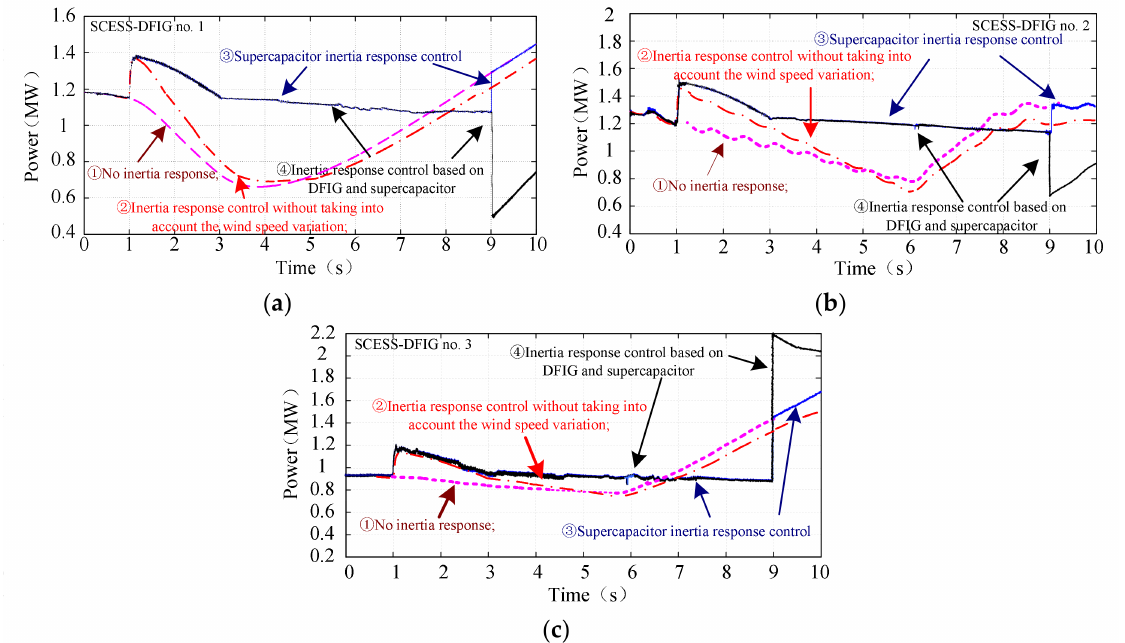
Figure 15. Comparison of the inertia response powers of the single SCESS-DFIG under different control strategies: ( a ) Single inertia power response under different control strategies for SCESS-DFIG no. 1; ( b ) Single inertia power response under different control strategies for SCESS-DFIG no. 2; ( c ) Single inertia power response under different control strategies for SCESS-DFIG no.